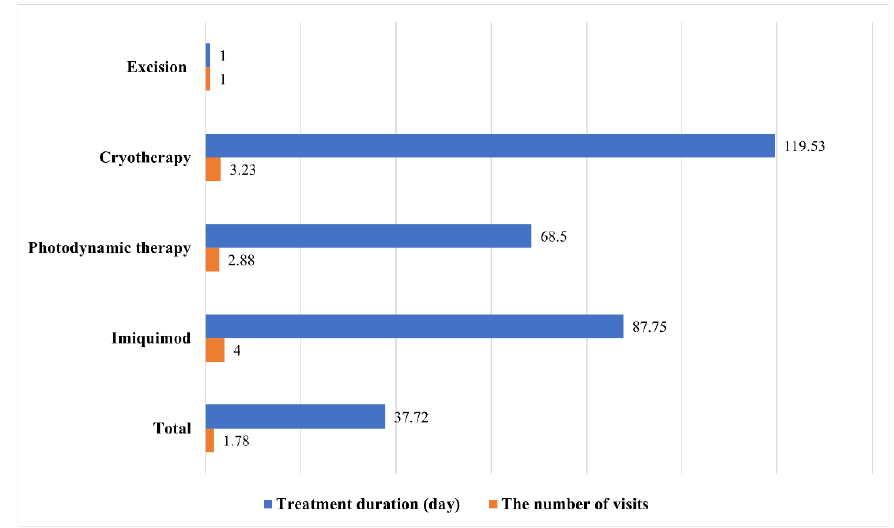
Figure 1. Average treatment duration and number of visits by treatment